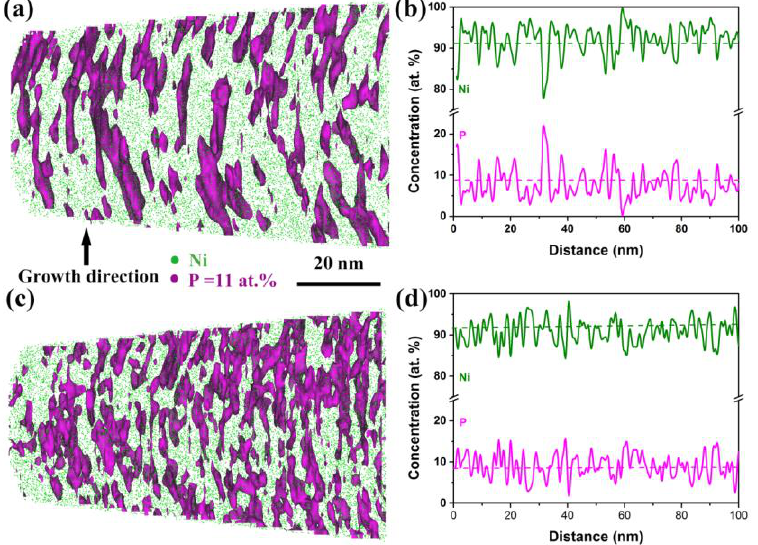
Figure 4. Three-dimensional atom probe tomography (3D-APT) analysis of solute elements distribution of ( a ) the as-deposited and ( c ) 325 °C for 0.5 h annealed Ni-7.1%P; ( b ) and ( d ) are the 1-D concentration profiles of the as-deposited and the annealed Ni-7.1%P, respectively.